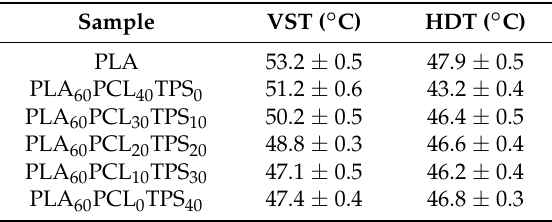
Table 5. Thermomechanical properties in terms of the Vicat softening temperature (VST) and heat deflection temperature (HDT) of the polylactide (PLA), poly( ε -caprolactone) (PCL), and thermoplastic starch (TPS) blend pieces.